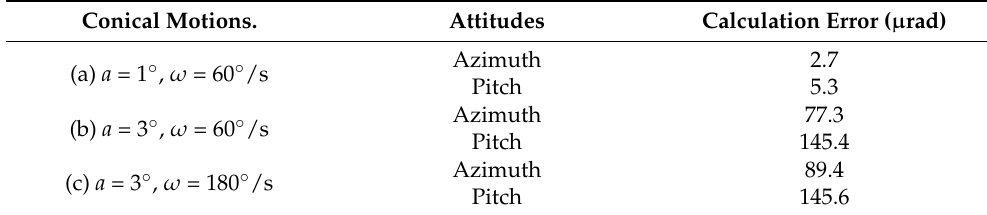
Table 2. The numerical calculation error ( µ rad) value (1 σ ) obtained using the direct calculation method. Conical Motions. Attitudes Calculation Error ( µ